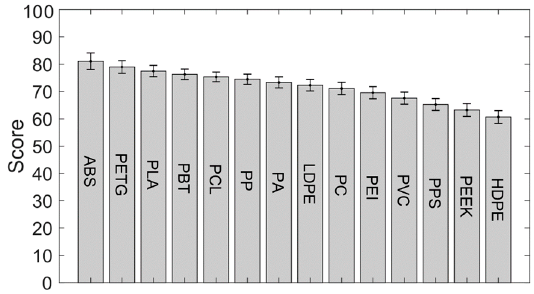
Figure 4. Sensitivity study on the ranking of the different polymers.